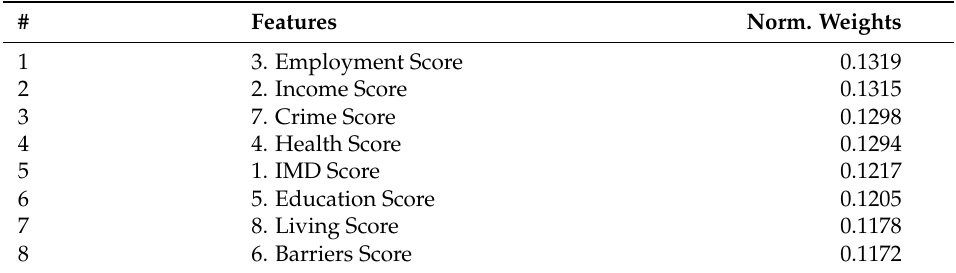
Table 3. Feature importance According to